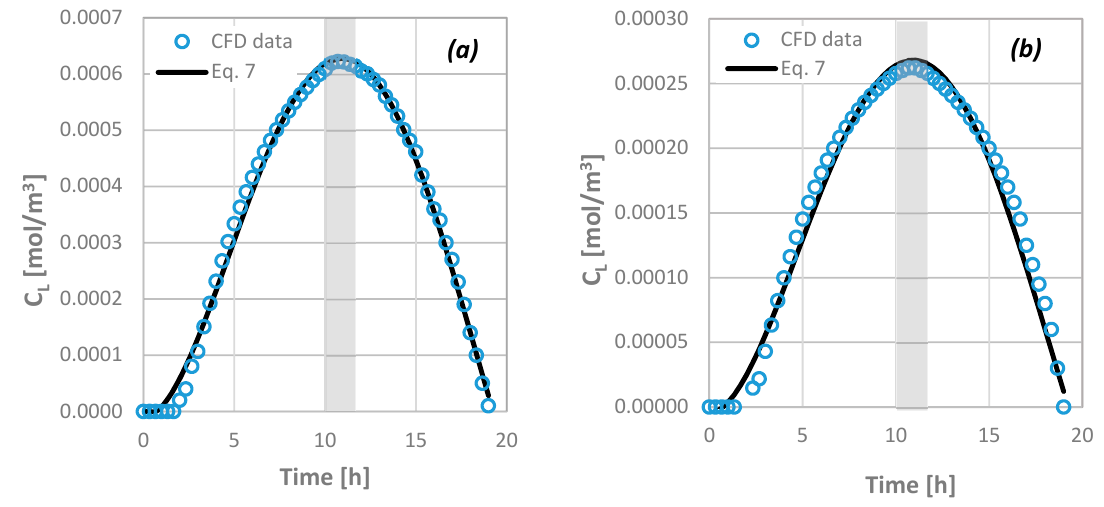
Figure 14. Comparison of computational fluid dynamics ( CFD) data concerning the concentration of agents at the bottom end of the porous disc as a function of time with the outcome of Equation (7) for: RDT = 2.5 mm, ϕ = 10%, R s = 2.2 nm and ( a ) M 0 = 0.10 mg/mL and ( b ) M 0 = 0.05 mg/mL.